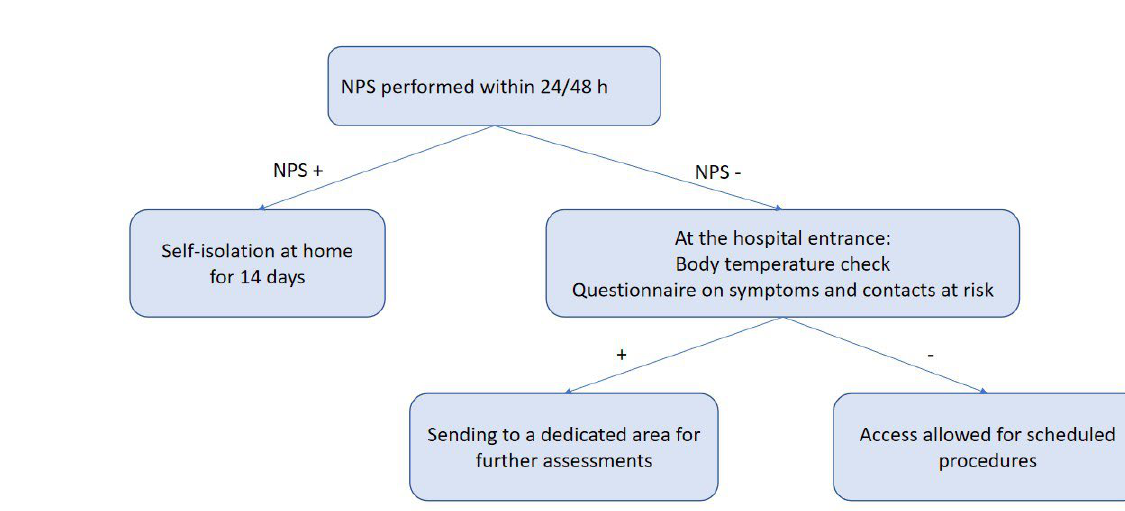
Figure 1. Flow chart of the COVID-19 screening protocol for outpatients